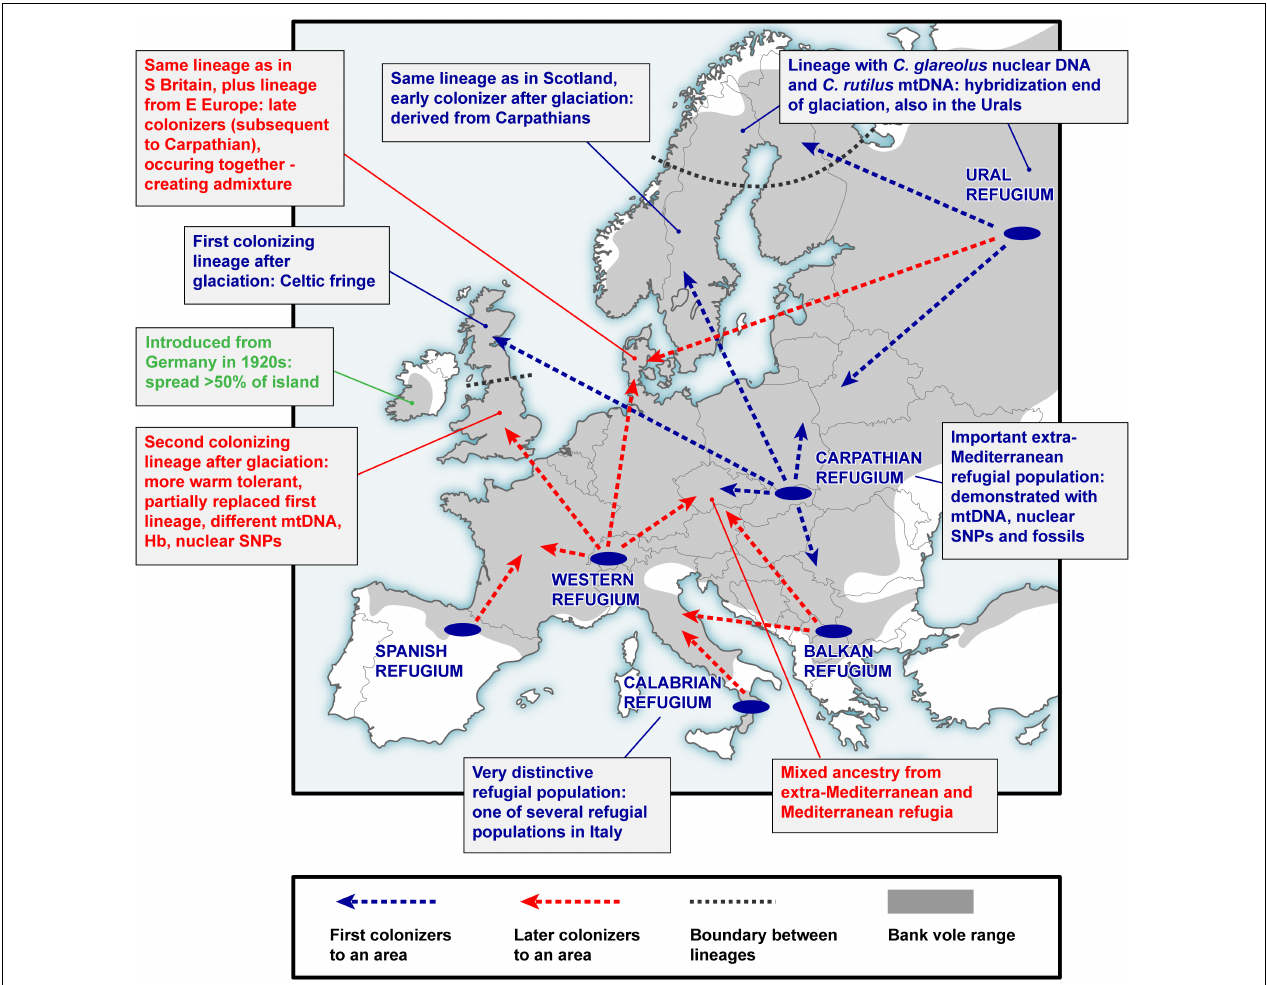
FIGURE 2 | A simplified scheme of bank vole colonization from glacial refugia in Europe. This represents a summary of over two decades of research on bank vole phylogeography, reviewed in this article.